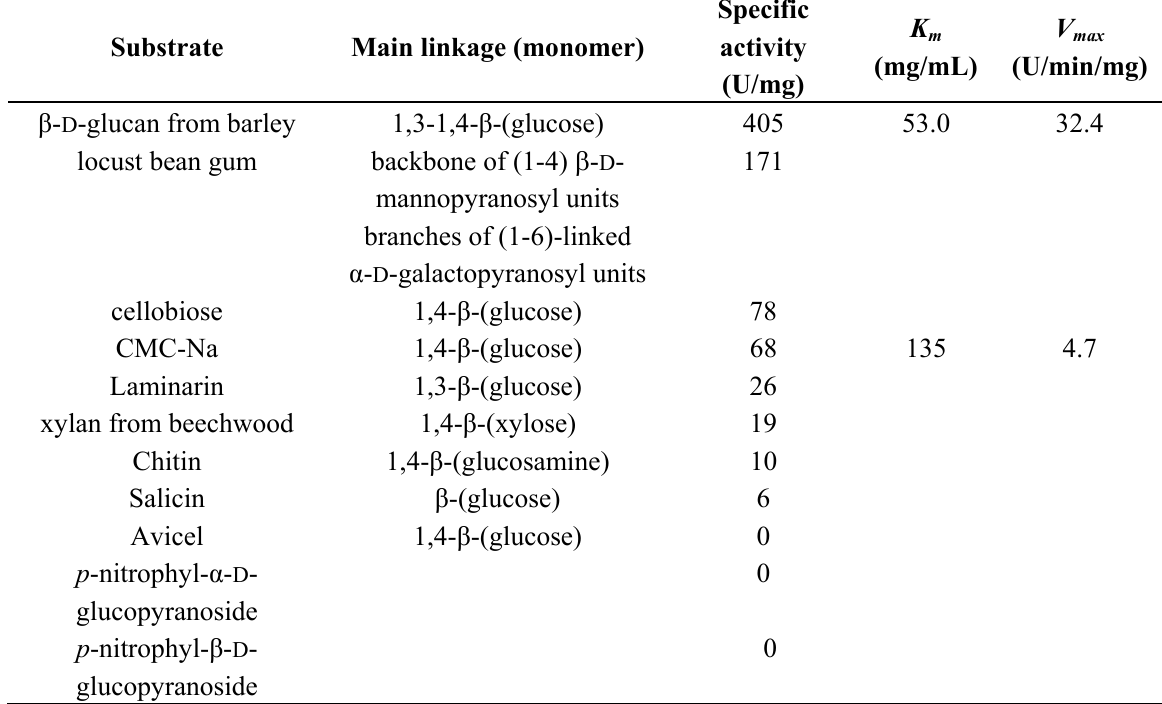
Table 1. Substrate specificity and kinetic parameters of the purified recombinant